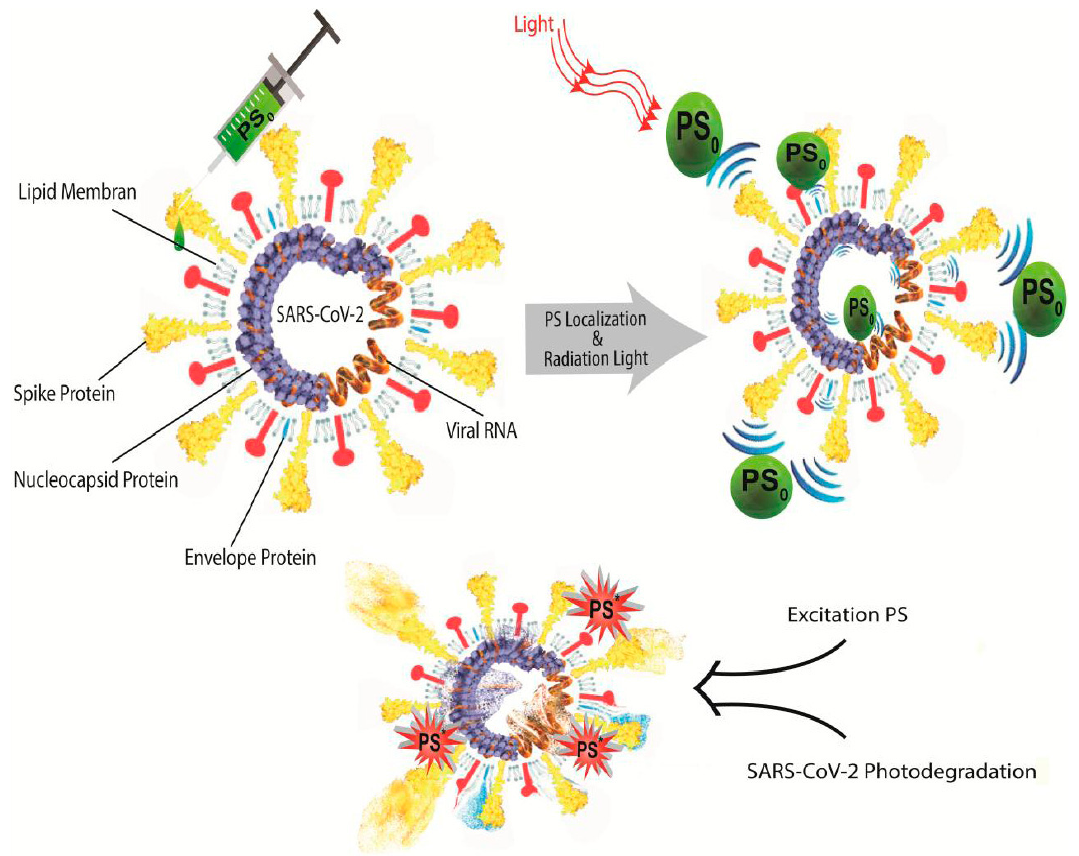
Figure 5. Schematic presentation of PDT protocol on the specific targets of SARS-CoV-2. This figure has been reprinted with permission from Ref. [199]. Copyrigt 2021, World Scientific.